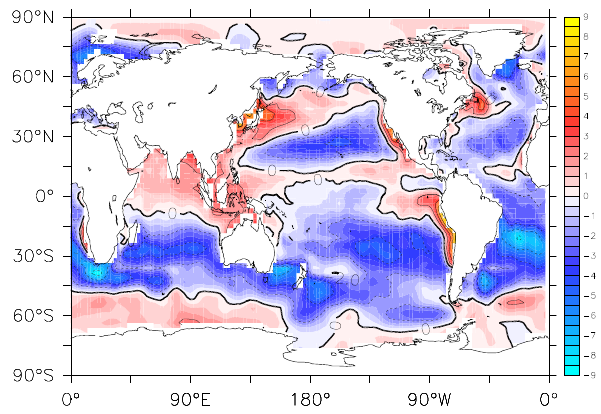
Fig. 8. The difference between the ensemble mean of the annual mean SST in SPEEDO and the SST according to Stephens et al. (2001) in K .